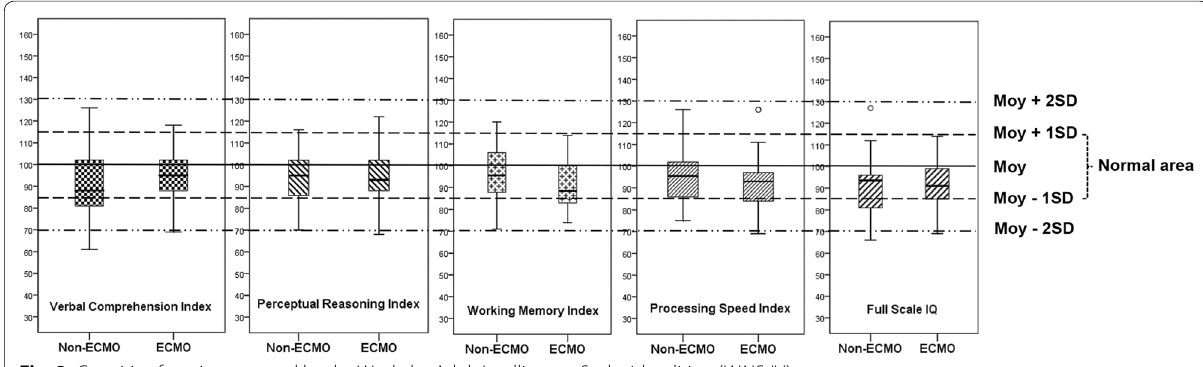
Fig. 2 Cognitive function assessed by the Wechsler Adult Intelligence Scale 4th edition (WAIS-IV)